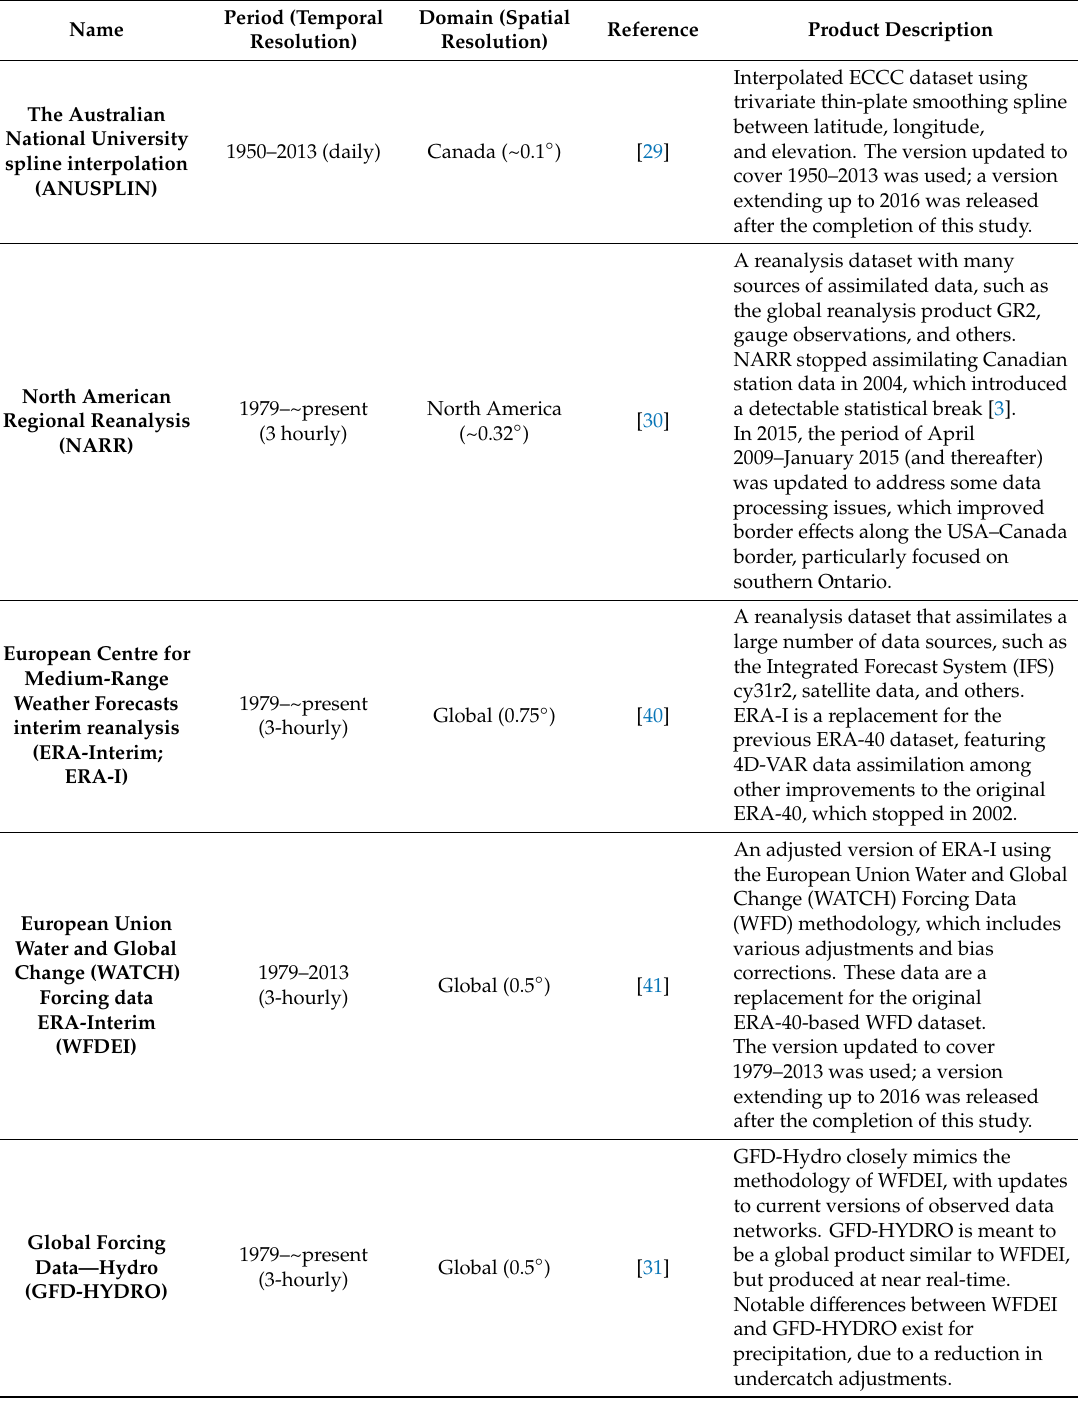
Table 1. Main characteristics of the five gridded climate datasets selected for the current